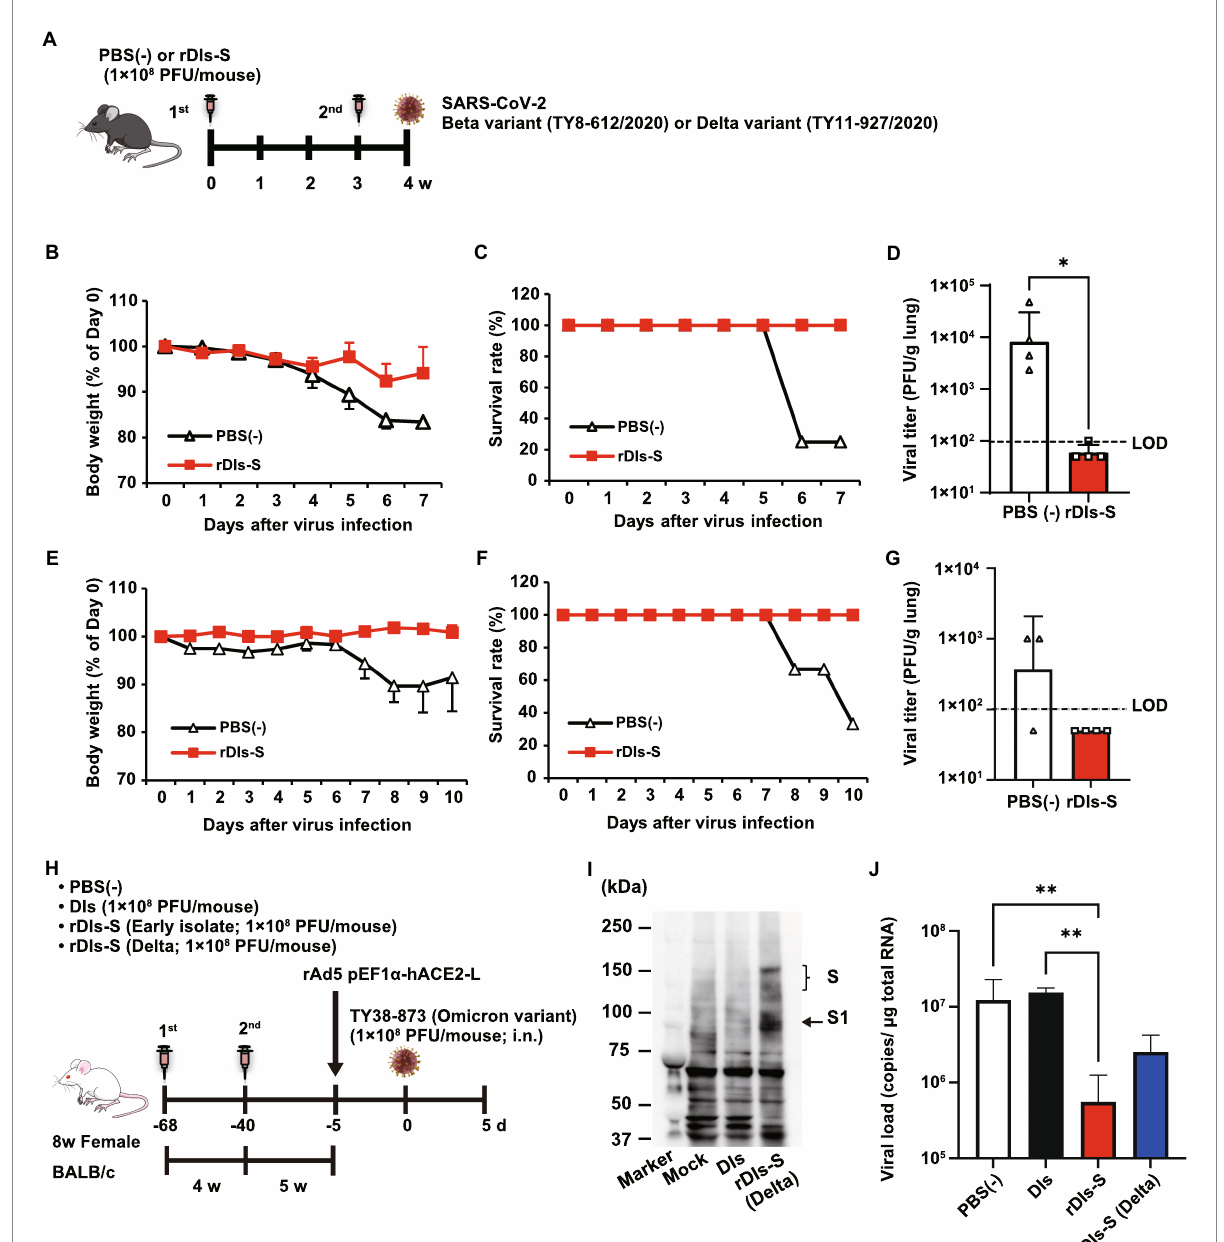
FIGURE 2 Immunization with rDIs-S protects mice from lethal challenge with SARS-CoV-2. (A) Experimental schedule in human angiotensin-converting enzyme 2 (hACE2) transgenic mice. hACE2 transgenic mice were inoculated twice intradermally with 1 × 10 8 PFU of rDIs-S or PBS( − ) with a 3-week interval, and then infected intratracheally with 100 PFU of a Beta variant (TY8-612) or 50 PFU of a Delta variant (TY11-927) SARS-CoV-2 strain 1 week after the second vaccination. (B–D) Protective effect of rDIs-S against challenge with a Beta variant of SARS-CoV-2 (TY8-612 strain; n = 4 per group). (B) Temporal changes in the body weight of hACE2 transgenic mice, with or without vaccination, after infection with the Beta variant. (C) Survival rate of hACE2 transgenic mice after Beta variant infection. (D) Infectious viral titers in left lung homogenates were measured by a plaque assay. The dashed line indicates the limit of detection (LOD; 100 PFU/g lung). Viral titers below the LOD are shown as 50. Value of p was calculated using a two-tailed non-paired Student’s t -test (* p = 0.0286). (E–G) Protective effect of rDIs-S against challenge with a Delta variant of SARS-CoV-2 (TY11-927 strain; n = 3–4 per group). (E) Temporal changes in the body weight of hACE2 transgenic mice after infection with the TY11-927 strain. (F) Survival rates after infection with the TY11-927 strain. (G) Infectious viral titers in left lung homogenates were measured by a plaque assay. The dashed line indicates the LOD (100 PFU/g lung). The pulmonary viral titers of unvaccinated mice are shown at the respective necropsy (8, 9, or 10 dpi). Viral titers below the LOD are shown as 50. (H) Experimental schedule in BALB/c mice. BALB/c mice were inoculated twice by epicutaneous immunization (skin scarification) with 1 × 10 8 PFU of rDIs-S (derived from an early-pandemic strain of SARS-CoV-2 or a Delta variant), DIs, or PBS ( − ) with a 4-week interval. Five weeks after the second vaccination, the mice were intranasally inoculated with 5 × 10 7 FFU of rAd5-pEF1 α -hACE2 and challenged with 1 × 10 5 PFU of an Omicron variant of SARS-CoV-2 5 days later. (I) Expression of the S protein derived from the SARS-CoV-2 Delta variant following infection with rDIs-S (Delta) was confirmed by western blot analysis. (J) Viral RNA in left lung homogenates was quantified by qRT-PCR. Value of p s was calculated using a two-tailed Kruskal–Wallis test, followed by a Dunn’s multiple comparison test. ** p < 0.01; ns, not significant; FFU, focus-forming unit; PFU, plaque-forming unit; and PBS, phosphate-buffered